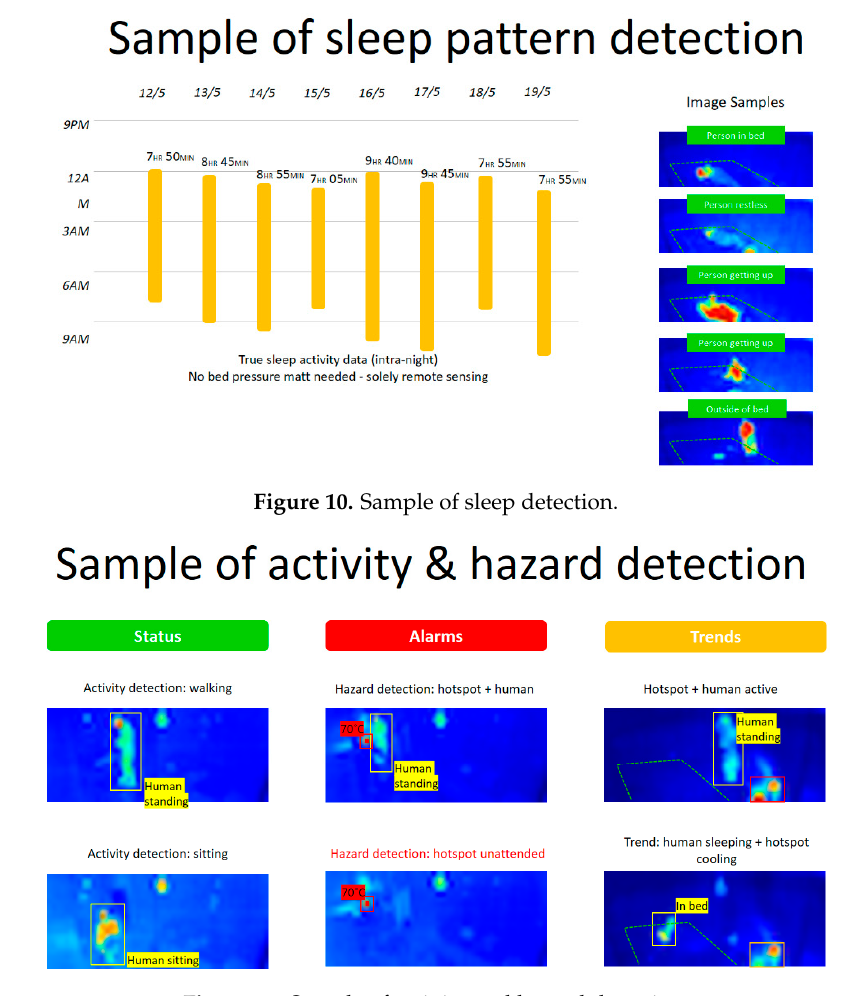
Figure 9. Dashboard review.